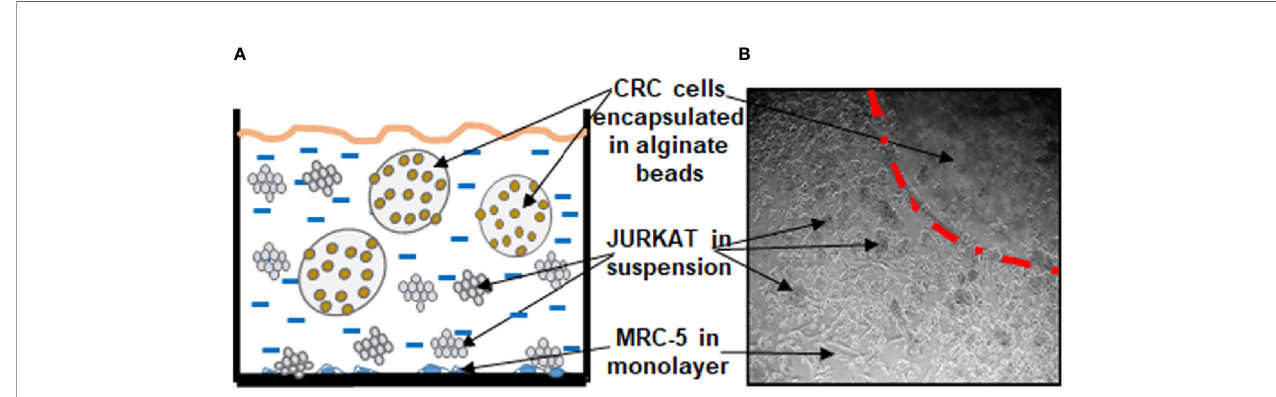
FIGURE 1 | Working model showingthe experimental procedures ofmulticellular proin fl ammatoryTME cultures as a scheme (A) and light microscopicphotograph (B)